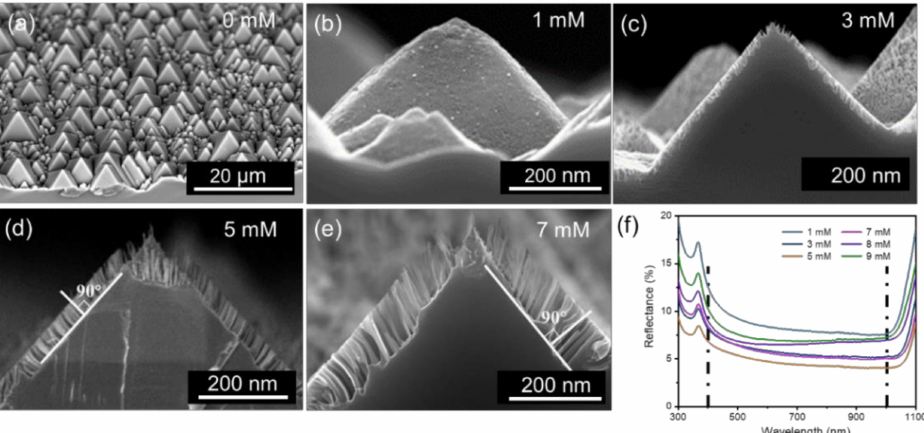
Figure 2. The devices produced using different AgNO 3 concentrations ( a – e ) SEM images. ( f )